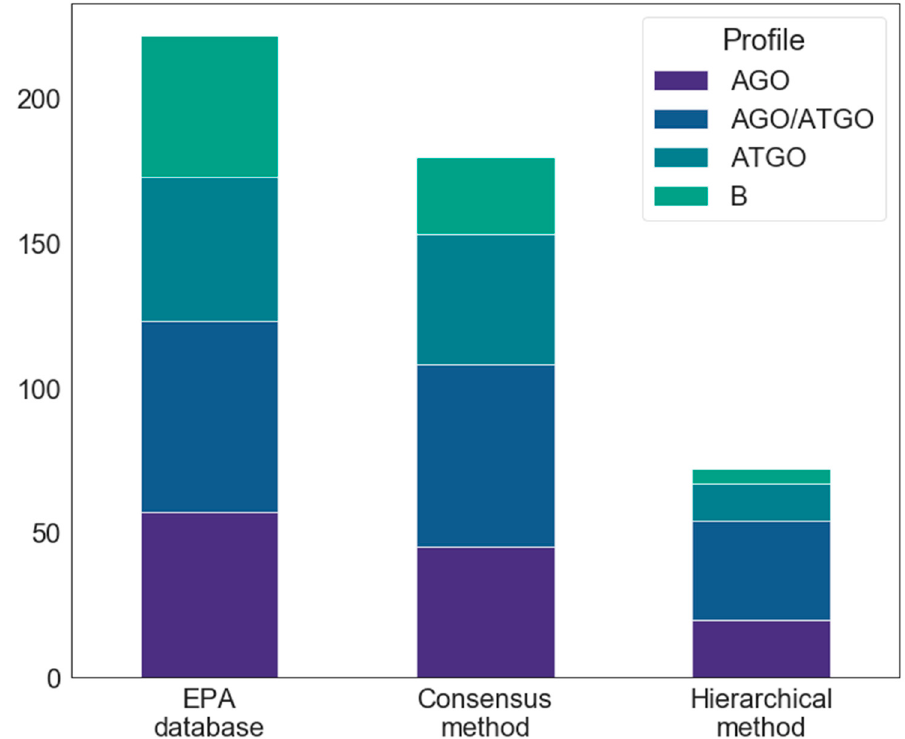
Figure 7. Barplots illustrating the relative proportion of compounds of each pharmacological profile (AGO: compounds with ER α agonist activity, ATGO: compounds with ER α antagonist activity, AGO/ATGO: compounds with both ER α agonist and antagonist activities, B: ER α binders without pharmacological profile annotation) in the EPA database and among the hits identified using the hierarchical and consensus protocols .